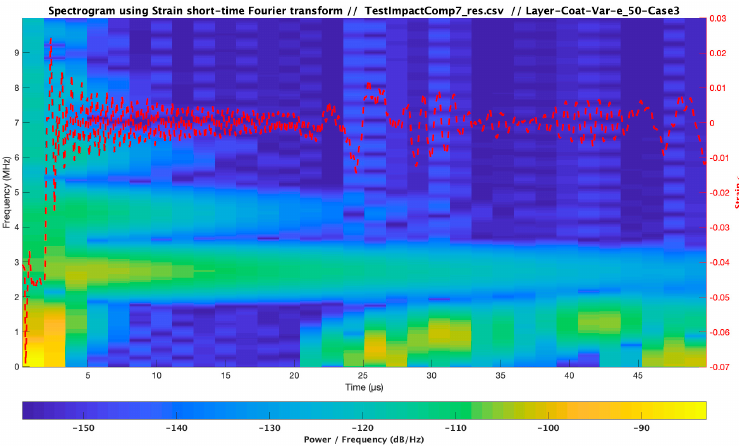
Figure 36. Spectrogram for strain evolution at the middle coating layer, 50% thickness, considering substrate-filler as semi-infinite with variation in droplet velocity. Case 3.